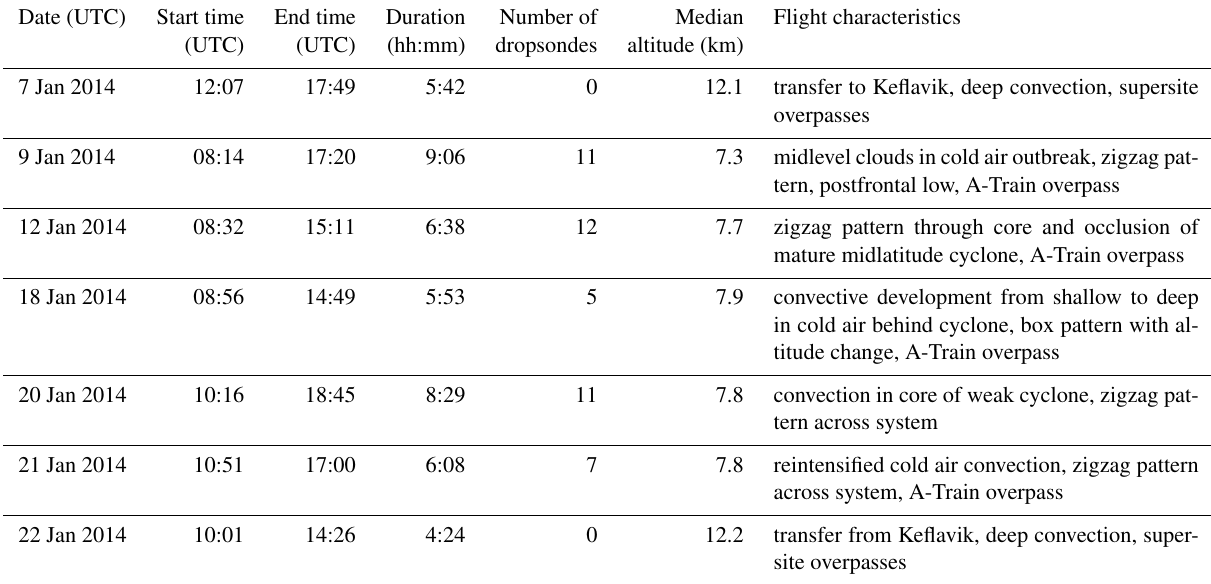
Table 2. List of NARVAL-North